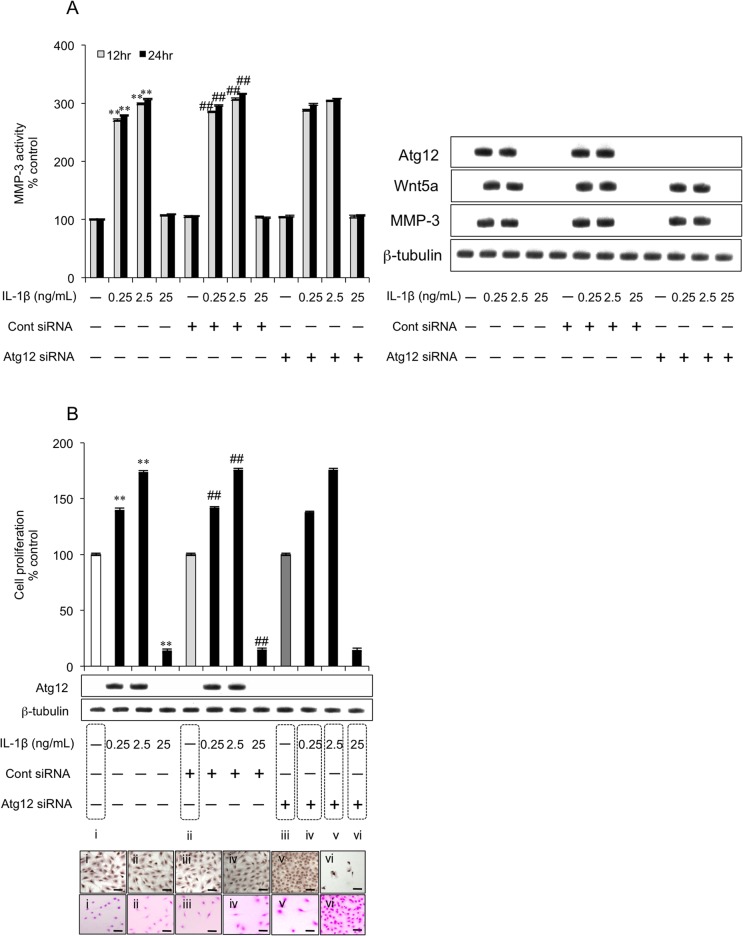
Effect of Atg12 siRNA on IL-1β-induced MMP-3 activity and cell proliferation.(A) E14Tg2a ES cell-derived odontoblast-like cells were transfected with Atg12 siRNA for 24 h and treated with IL-1β (0, 0.25, 2.5 and 25 ng/mL) for either 12 h (grey bars) or 24 h (black bars), prior to carrying out an MMP-3 activity assay (left) and western blotting for Atg12, Wnt5a and MMP-3 (right). (B) BrdU-cell proliferation ELISA (for cell proliferation; graphs), BrdU Immunohistochemistry Kit (for cell proliferation; images, upper row), and APOPercentage Apoptosis Assay Kit (for apoptosis; images, lower row). β-tubulin was used as a housekeeping protein in western blots. **P < 0.01 vs. control; ##
P < 0.01 vs. control siRNA; †
P < 0.01, as indicated by the bracket. The BrdU ELISA kit stains the nuclei of proliferating cells dark brown. Accumulation of dye (pink-purple) denotes apoptosis in the APOPercentage kit. Images are representative of at least three independent experiments. Scale bars = 100 μm.